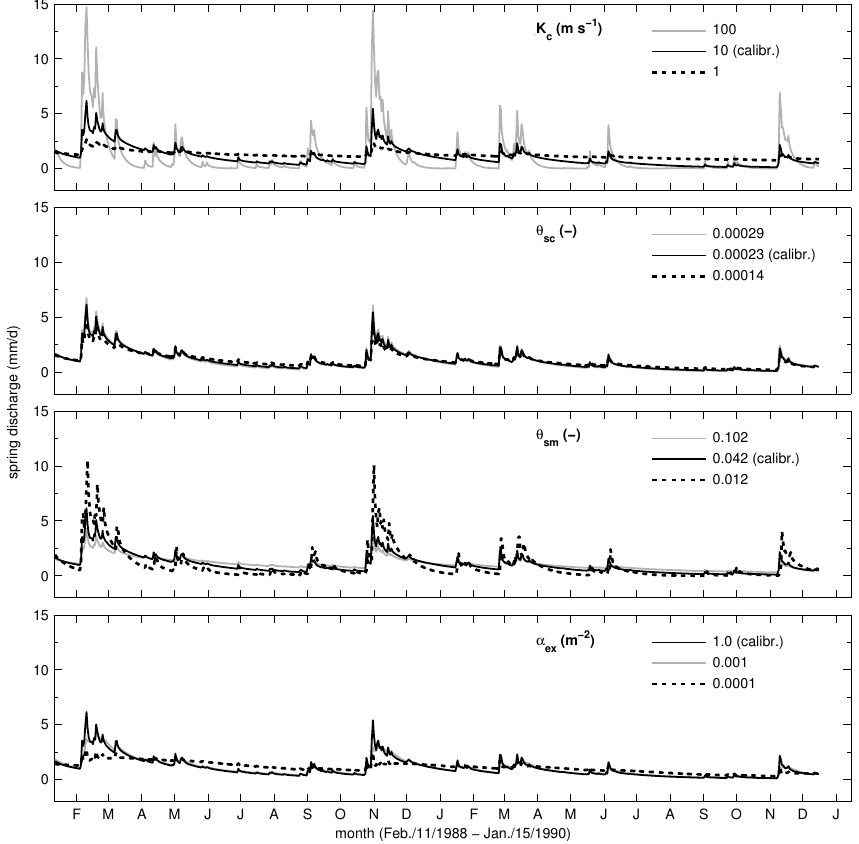
Fig. 6. Variation of hydraulic parameters ( K c , θ sc , θ sm ) and the exchange parameter ( α ex ).